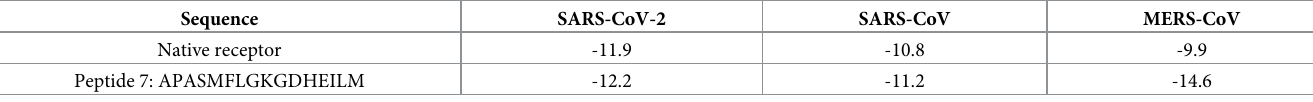
Table 2. Comparison of the binding energy ( Δ G) between the native receptor and Peptide 7. Sequence Native receptor Peptide 7: APASMFLGKGDHEILM All values are in kcal mol -